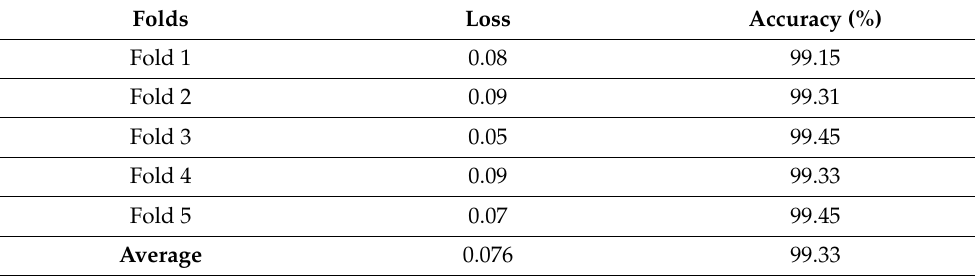
Table 4. Evaluation and characteristics of the proposed model.